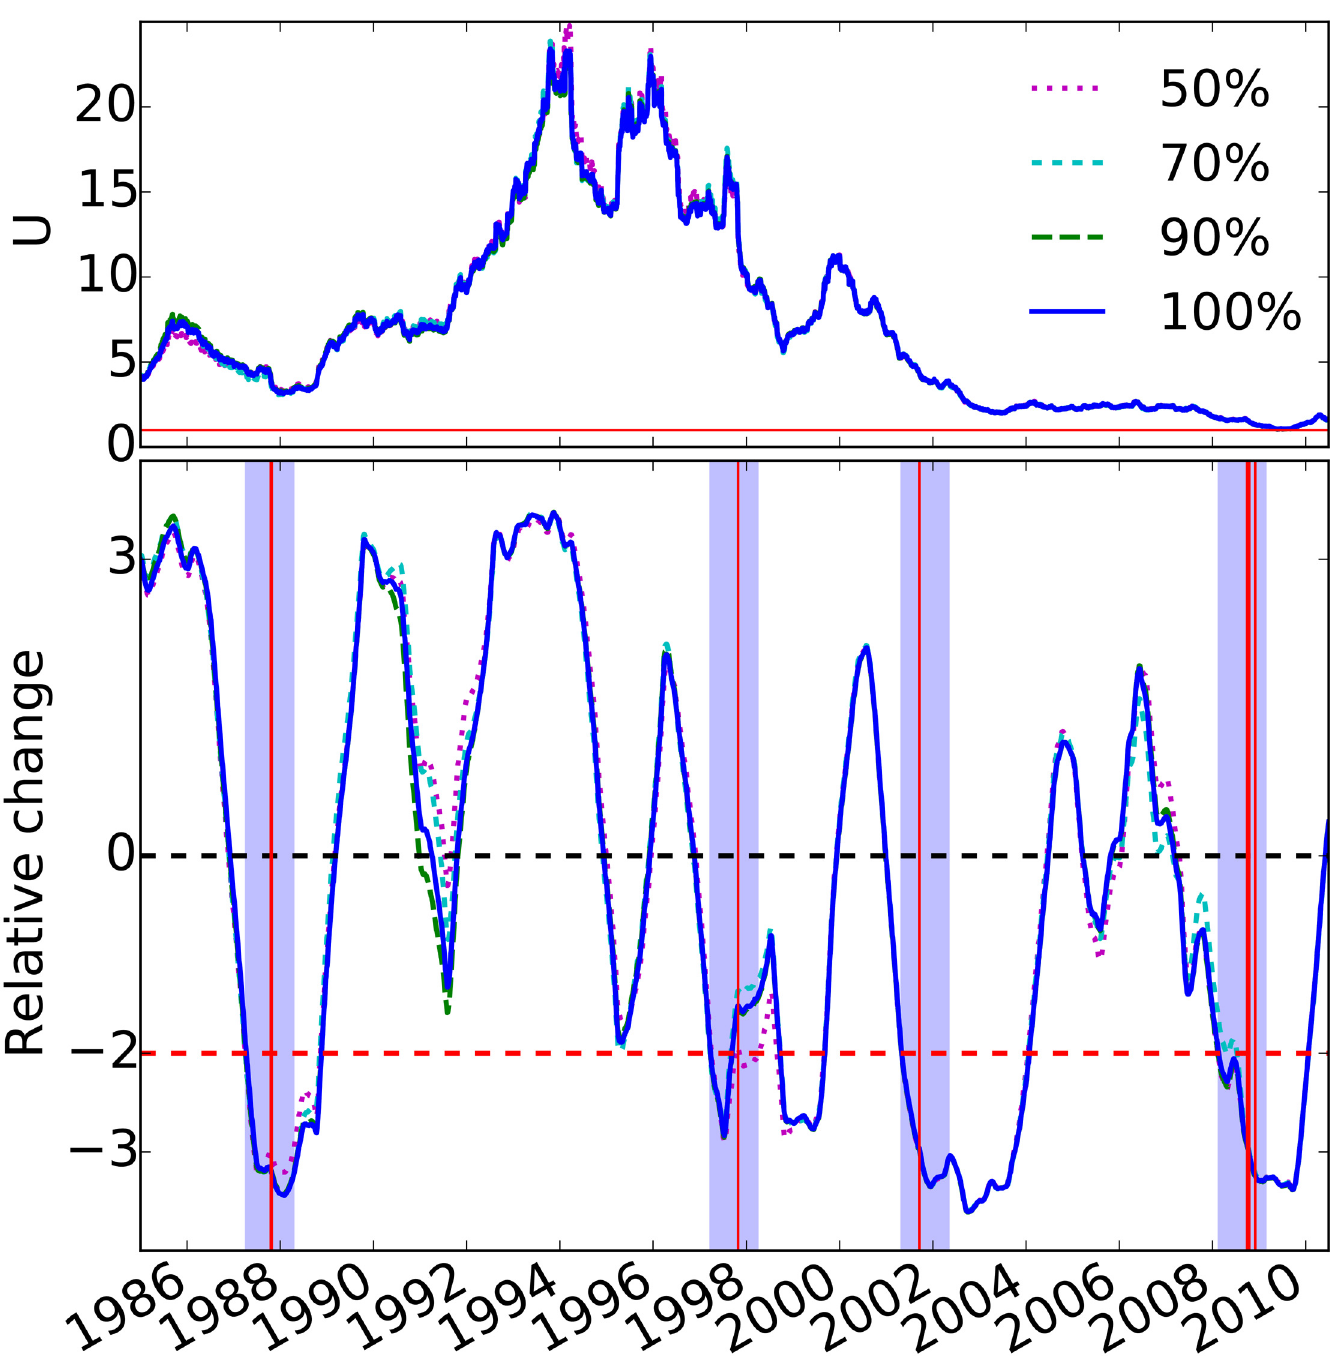
Fig 5. Model parameter (top panel) and relative change (bottom panel) in model parameter U for the period 1985 – 2010, for varying subsamples of stocks. Similar to that of the top panel of Fig 3, but for different subsamples of stocks of 50%, 70%, 90%, and 100% of the entire sample used in Fig 3. Positive-return distributions are computed from the daily returns of stocks included in the corresponding subsamples. The original analysis is robust, with four true positives, i.e., no false positives or negatives, for the 70%, 90%, and 100% subsamples. One false positive is introduced for the 50% subsample due to the reduced sample